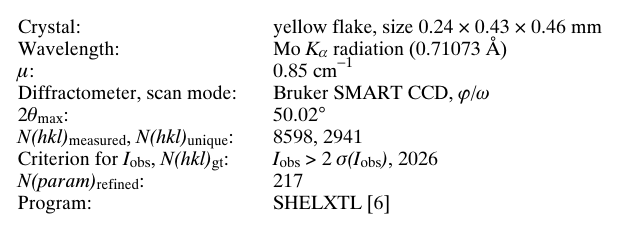
Table 1. Data collection and handling.